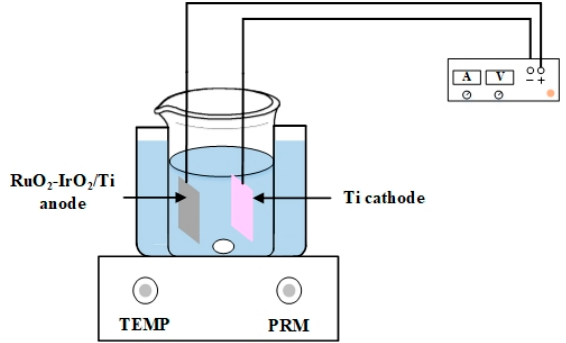
Figure 8. Schematic of the EC/Fe 3+ /PDS system.